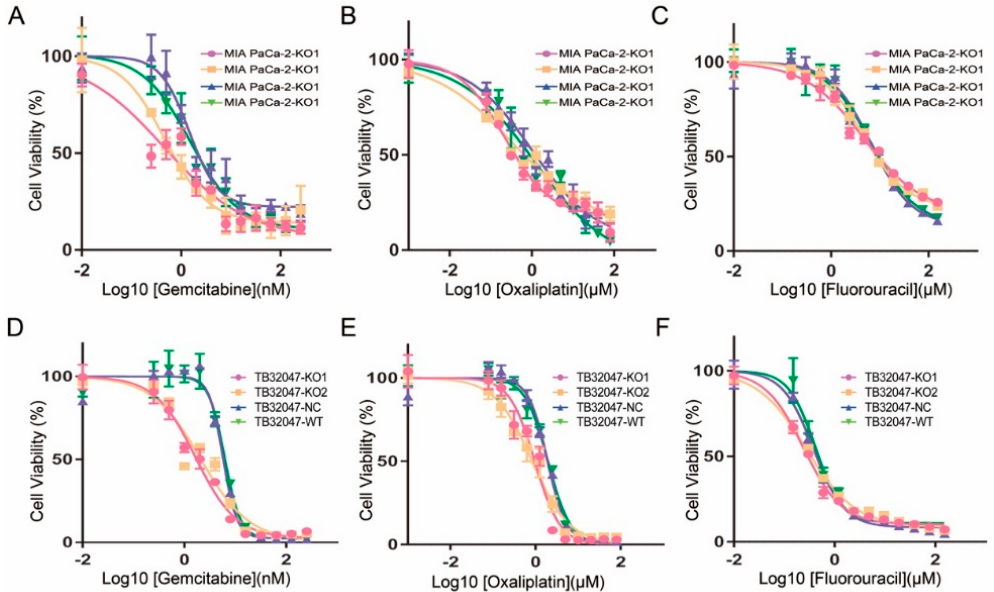
Table 2. The EC50 values and 95% CI (Confidence Interval) of chemotherapy drugs in cells.